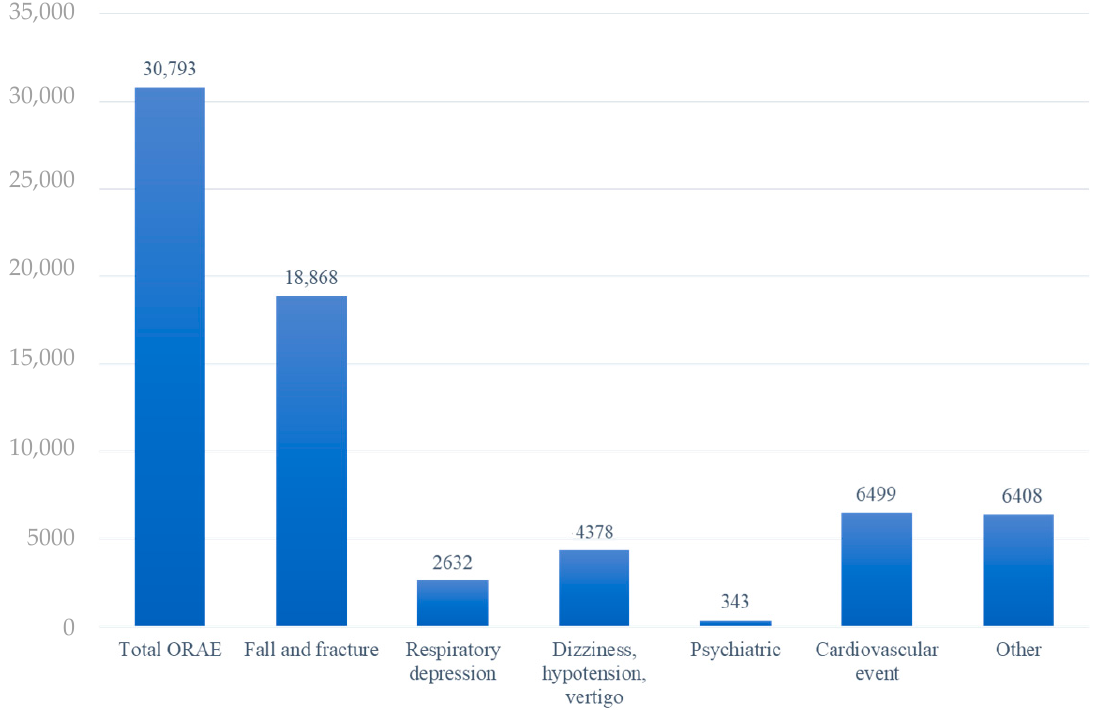
Figure 2. The number of opioid-related emergency department visits. Other: Nausea/vomiting, constipation, dry mouth, pruritus, urinary incontinence. Abbreviations: ORAE, opioid-related adverse drug